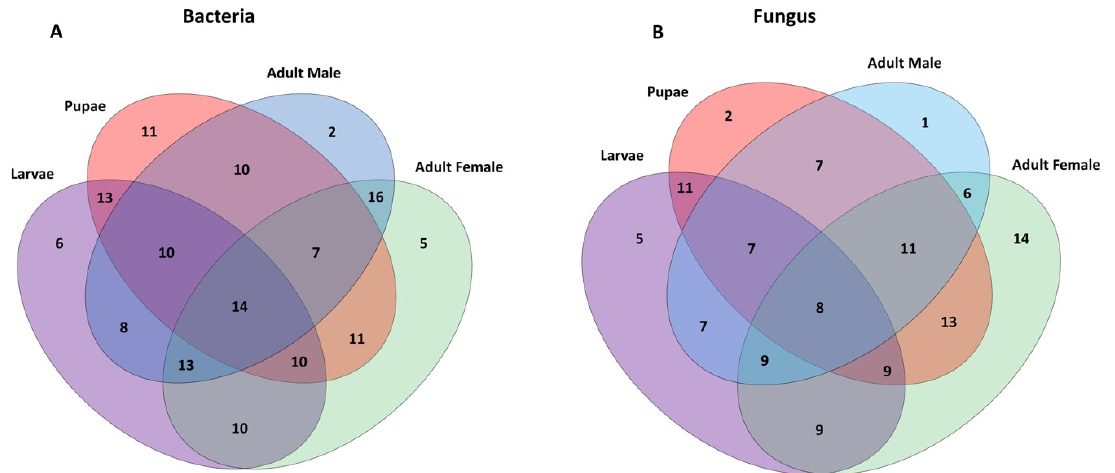
Figure 1. Venn diagram of the ( A ) bacterial and ( B ) fungal genera present in di ff erent developmental stages of the Qfly.